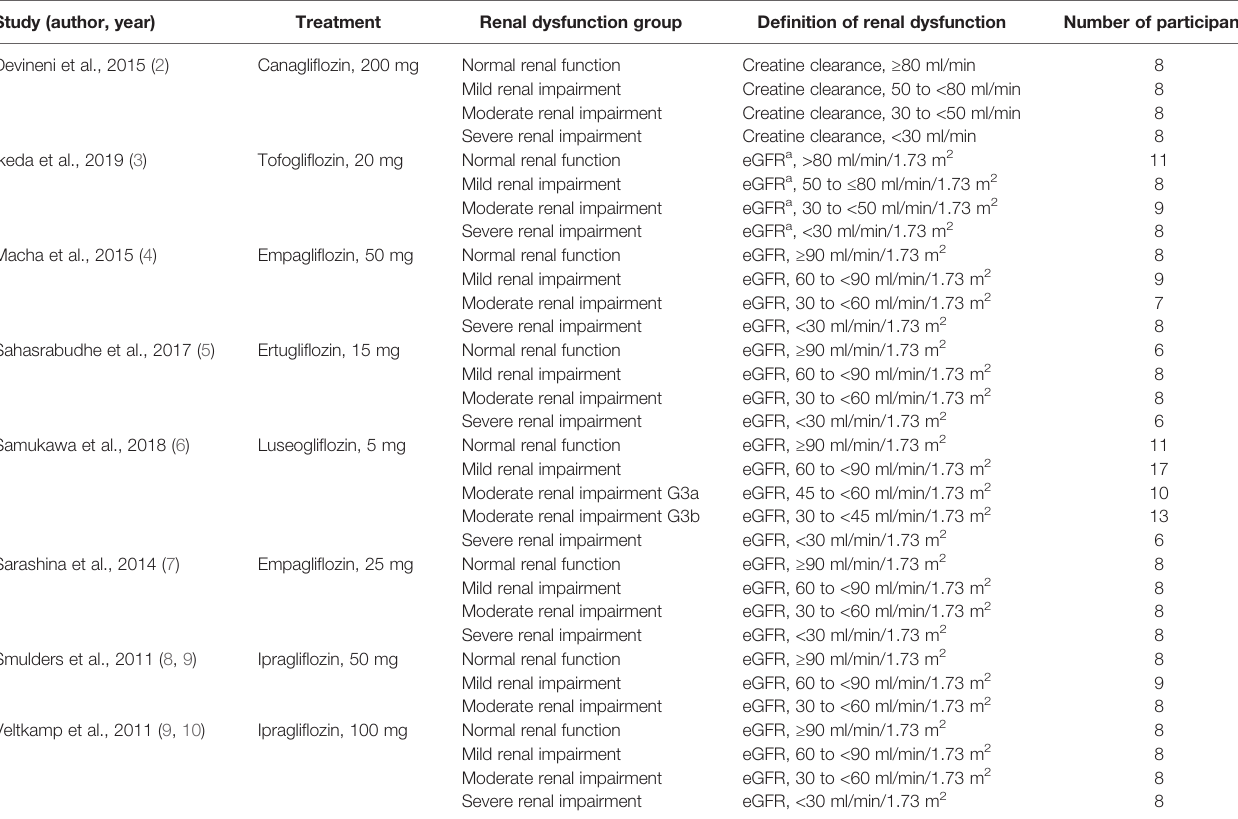
TABLE 1 | Baseline characteristics for studies of urinary glucose excretion assessment in patients with renal